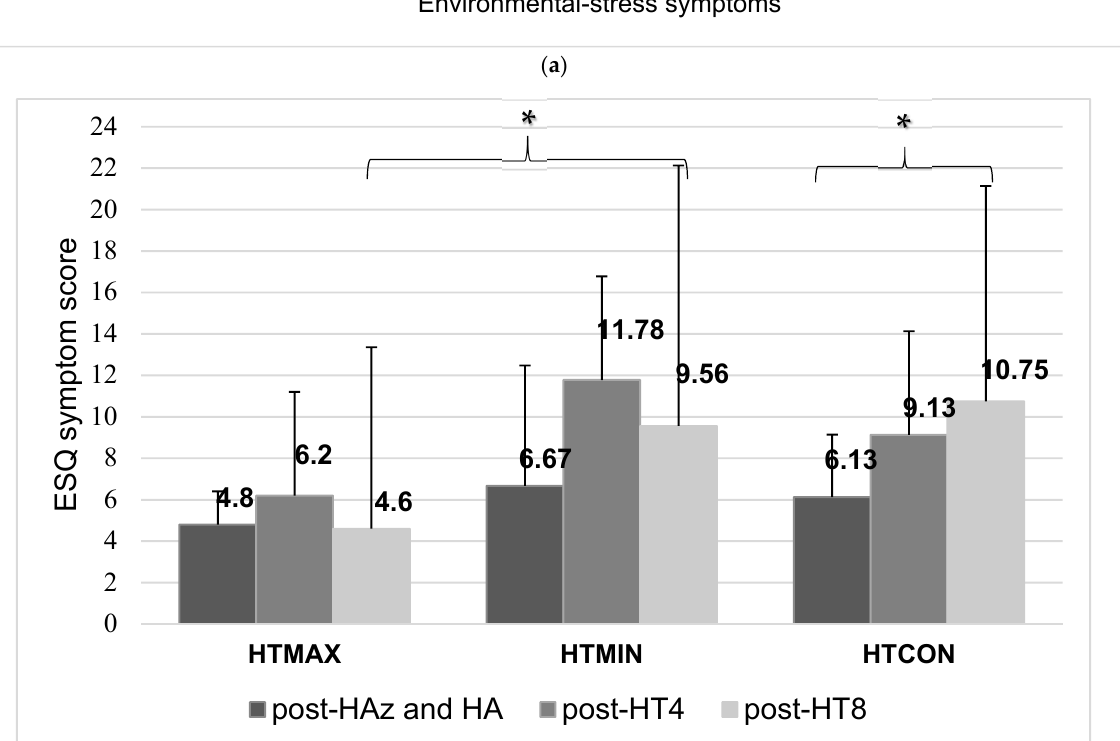
average post-trial symptom scores during HT. ( b ) Visual representation of change from post-trial trial to pre-trial Environmental Symptoms Questionnaire (ESQ) symptom scores over the course of